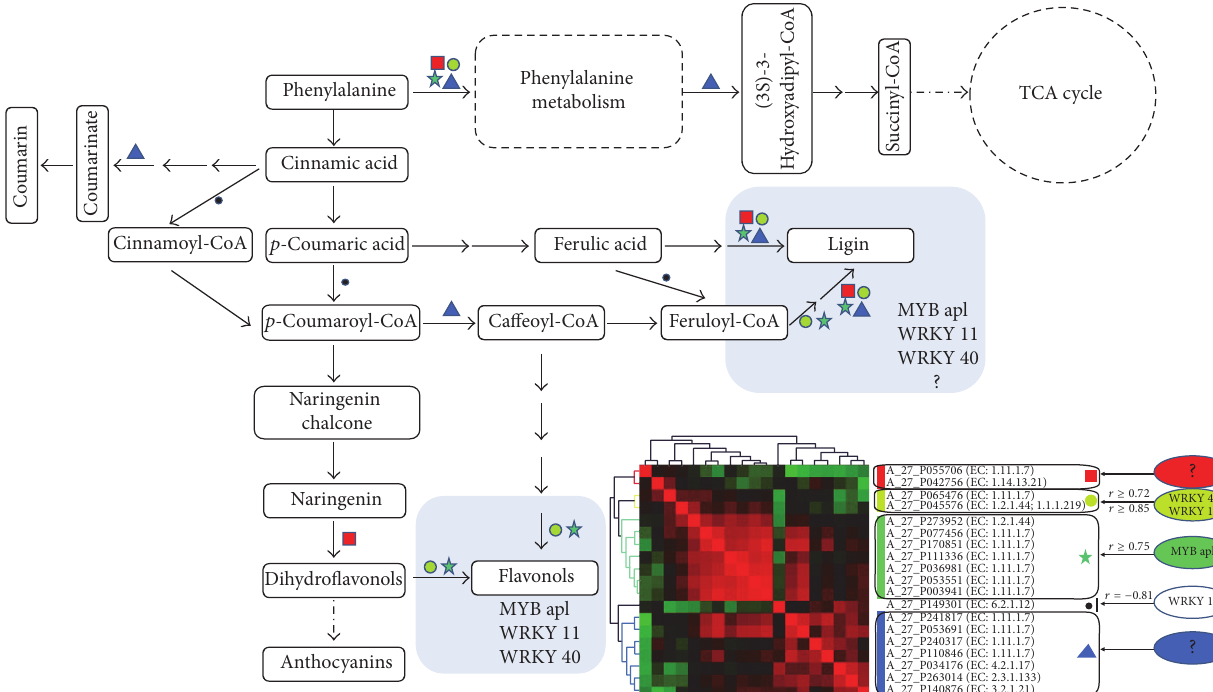
Figure 7: Pathways in response to acid-Al ions based on KEGG analysis. Overview of the combinations of the phenylpropanoid biosynthesis, phenylalanine metabolism, and flavonoid biosynthesis pathways in response to acid-Al ions based on KEGG analysis. Nineteen genes were differentially expressed in response to acid-Al ions. Hierarchical clustering of the results of the correlation coefficient analysis was shown in the lower right corner. The divided groups were marked by different shapes and color icons, which were also marked in the metabolic pathway. High positive correlation coefficient with genes in the divided groups were shown near the image of the hierarchical clustering analysis and also marked in the light shadow zone of the metabolic